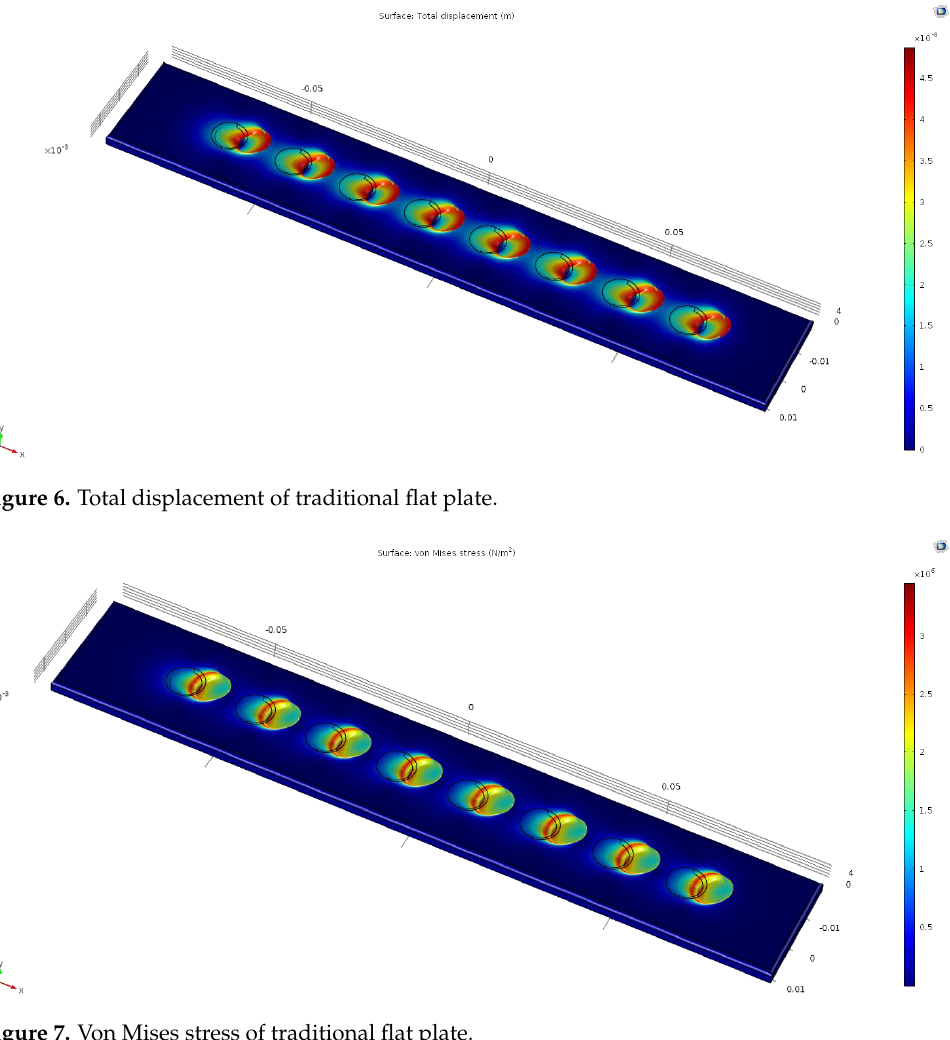
Figure 8. First principal strain of traditional flat plate. 3.2. Flat Newly Developed Plate Design The FEA result of the newly developed flat bone plate is illustrated in Figures 9 – 11. Generally, this implant is stronger and more stable than the traditional flat plate. Based on the data in Table 2, the newly developed plate has a maximum displacement of only 39%, maximum von Mises stress of only 42%, and maximum first principal strain of only 44% of the traditional flat plate. It, however, has an average displacement of 4.53 nm or about 25% higher; and both average von Mises Stress and first principal strain about 18% higher, in contrast to the traditional flat plate. The length of the plate may be the cause of the improvement in the results of all analyses, considering that the increase in length helps to decrease the magnitude of the load acting per point area. The circled body on both ends of the plate also increases the total surface area, increasing the grip strength while also reducing the force.